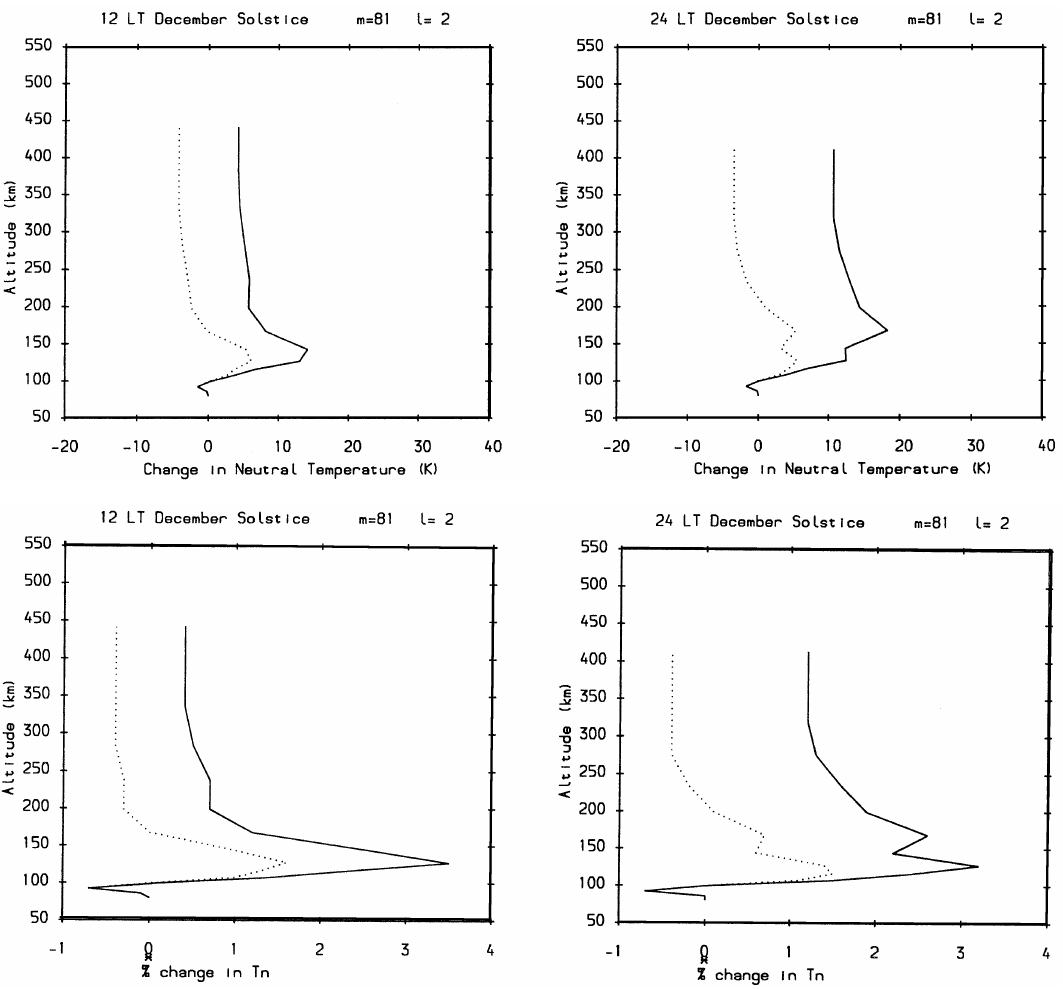
Fig. 5. Altitude profiles of the change of T n at local noon and midnight over EISCAT. The solid (broken) lines represent the change from (cid:15) 6 = 1 to (cid:15) 6 = 1 . 4 ( (cid:15) 6 = 1 .